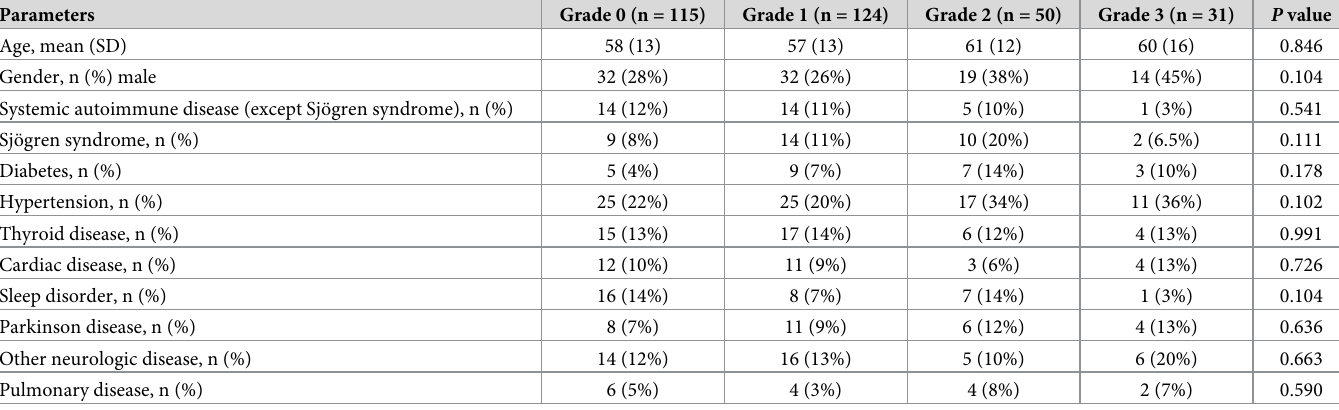
Table 3. Demographics of semiquantitative results of MMP-9 point-of-care test.